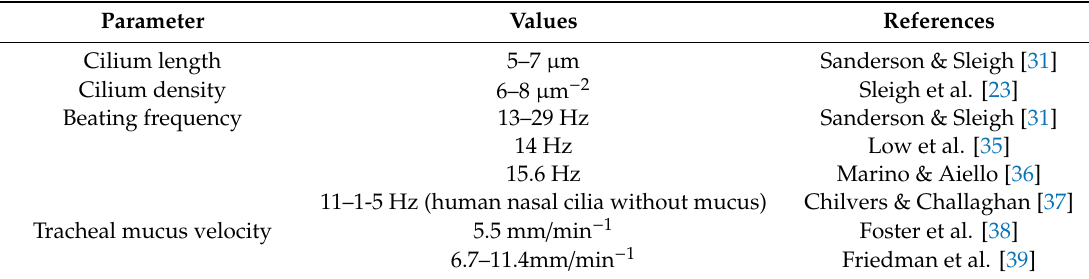
Table 1. Parameters of cilia that are important for mathematical modeling. Courtesy of Xu and Jiang [34].